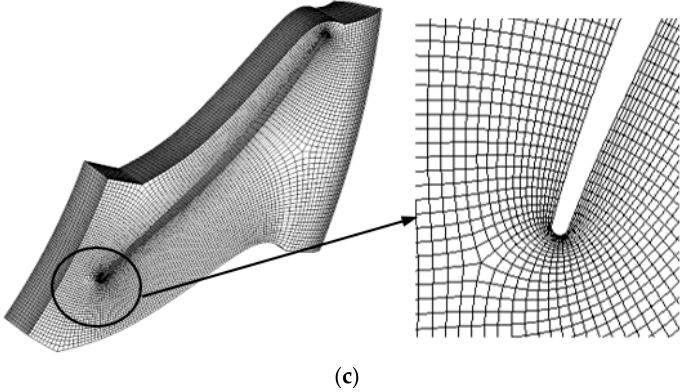
Figure 6. A three ‐ dimensional CFD mesh: ( a ) grids of the combined compressor; ( b ) grids of the impeller; ( c ) grids of the radial diffuser.